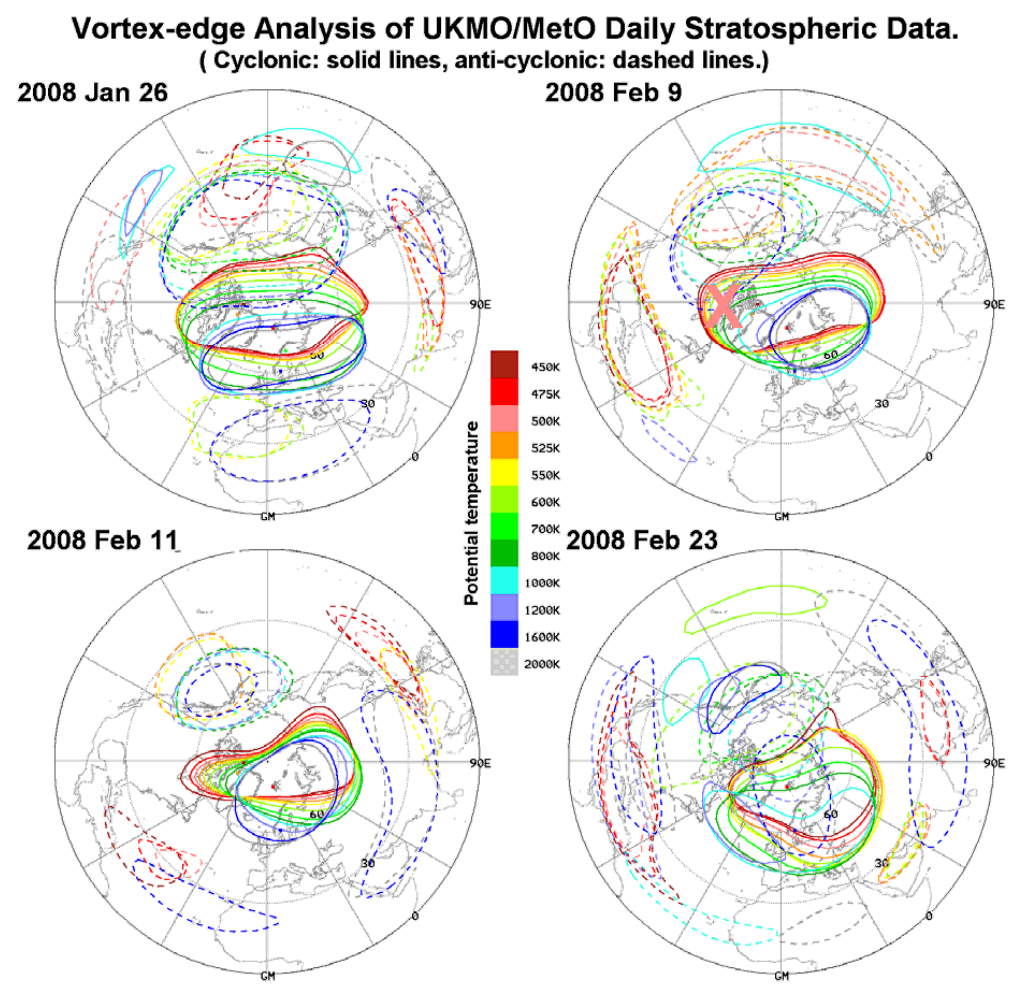
Fig. 7. Same as Fig. 4, but for 26 January, 9, 11 and 23 February 2008. A “ × ” symbol marks the region with low O 3 mixing ratios near 20km (500K) in the 9 February 2008